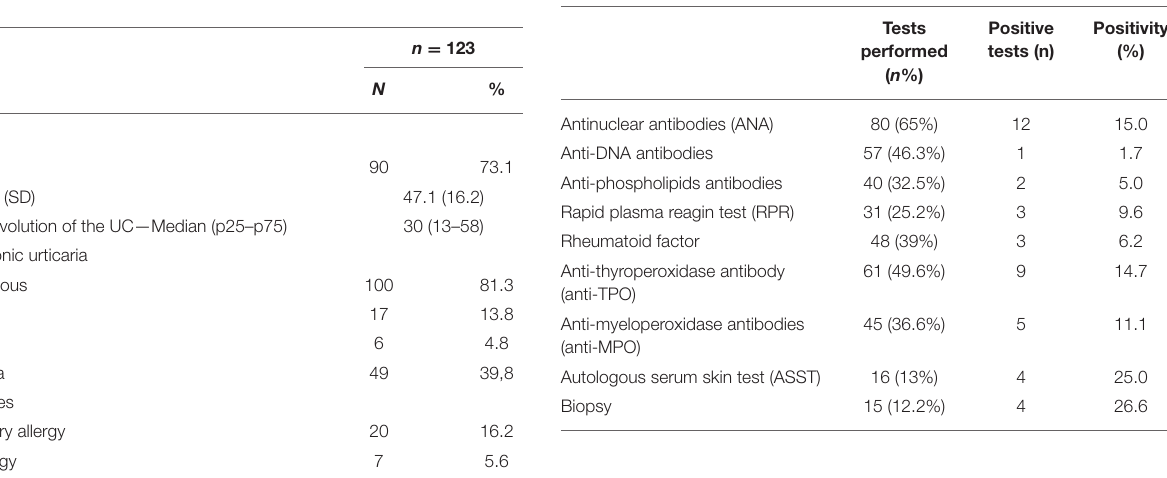
TABLE 2 | Paraclinical tests recorded in the